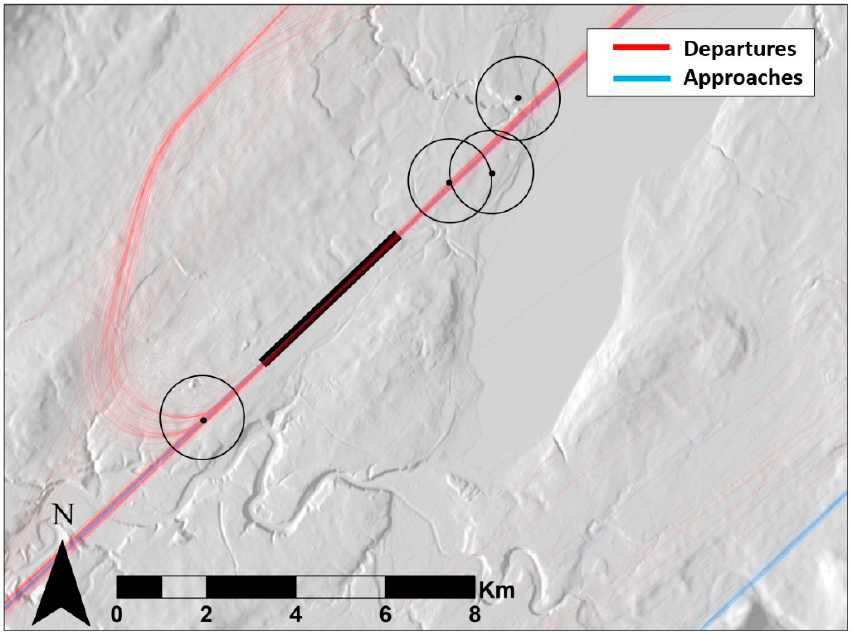
Figure 2. Noise monitoring terminals (NMT) in close range to GVA with all flight trajectories used for this study, colored by procedure. The black circles around each terminal represent spatial gates, which the flight trajectories have to penetrate to be considered (basemap: swissALTI3D LV95, swisstopo; source: Federal Office of